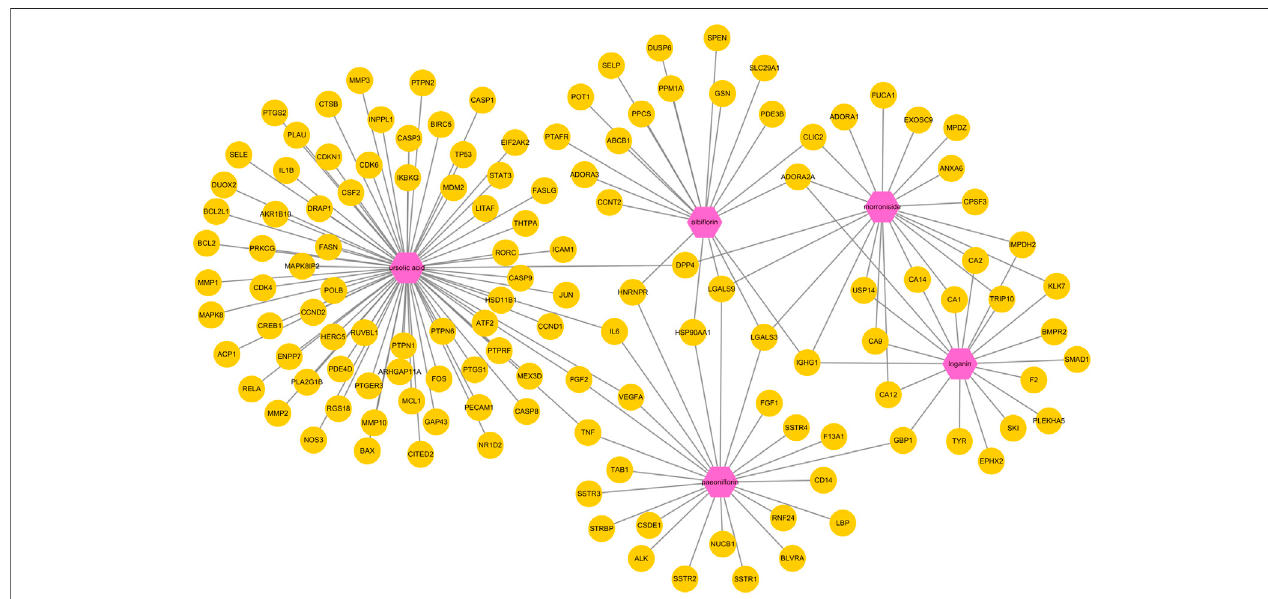
FIGURE 5 | Pharmacological network map illustrating compound-targets relationships. The active compounds investigated in this study are displayed in pink hexagons and their targets are shown in yellow circles. Genes that are the target of two or more compounds are revealed by identifying the targets with multiple connections (degrees).